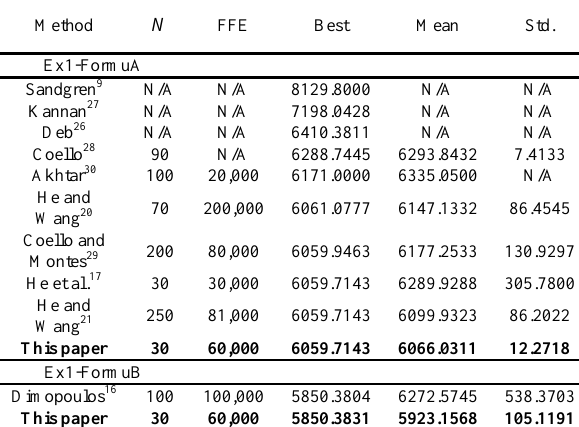
Table 5. Statistical results of different methods for the pressure vessel design